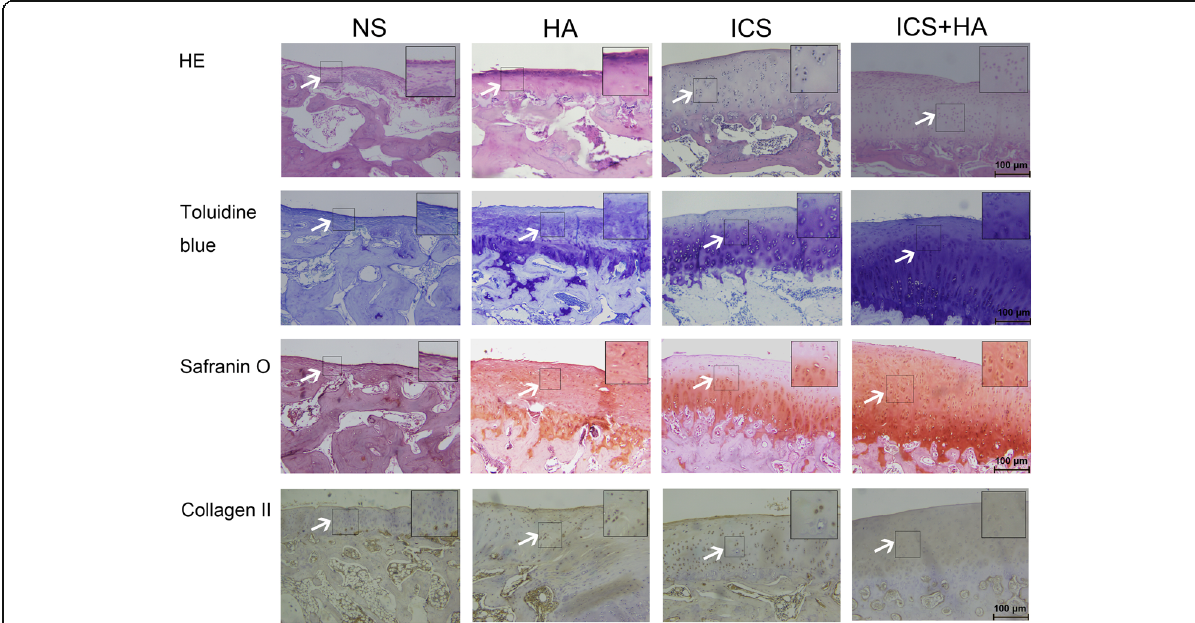
Fig. 4 Histological and immunohistochemical analysis of osteochondral defects repair in rabbit knees. Arrows pointed out the significant changes of regenerated tissues in the four